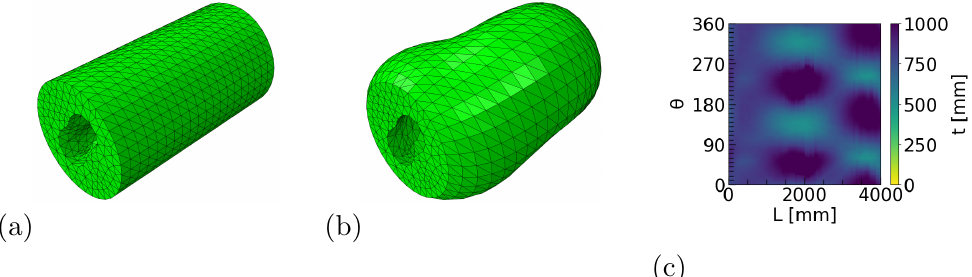
Figure 5. ( a ) Undeformed initial geometry (stationary). ( b ) Deformed initial geometry (rotating). ( c ) Wall thickness variation of initial